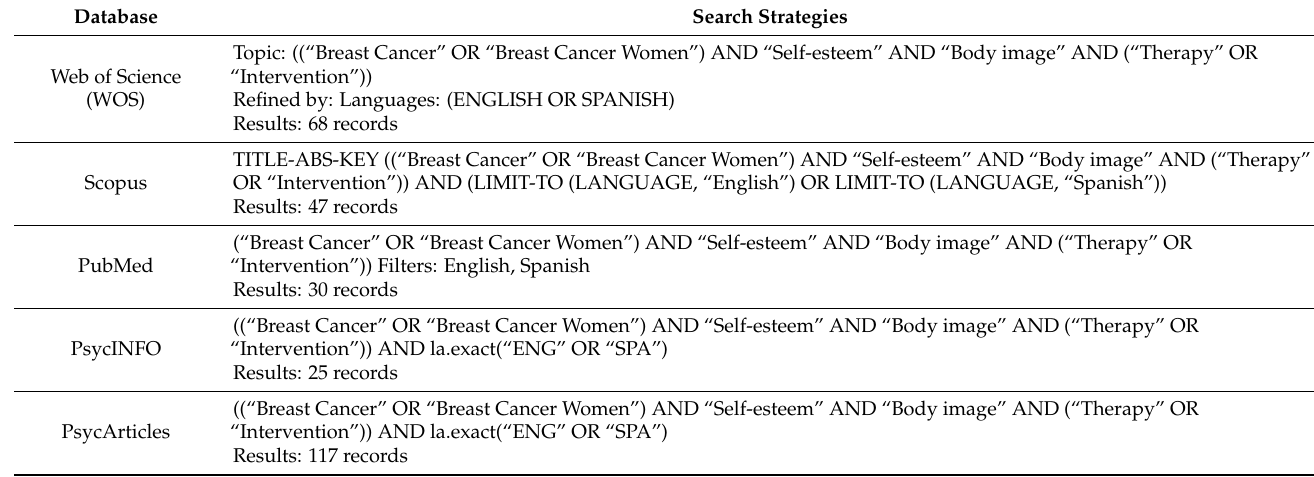
Table 1. Search strategies used. Search